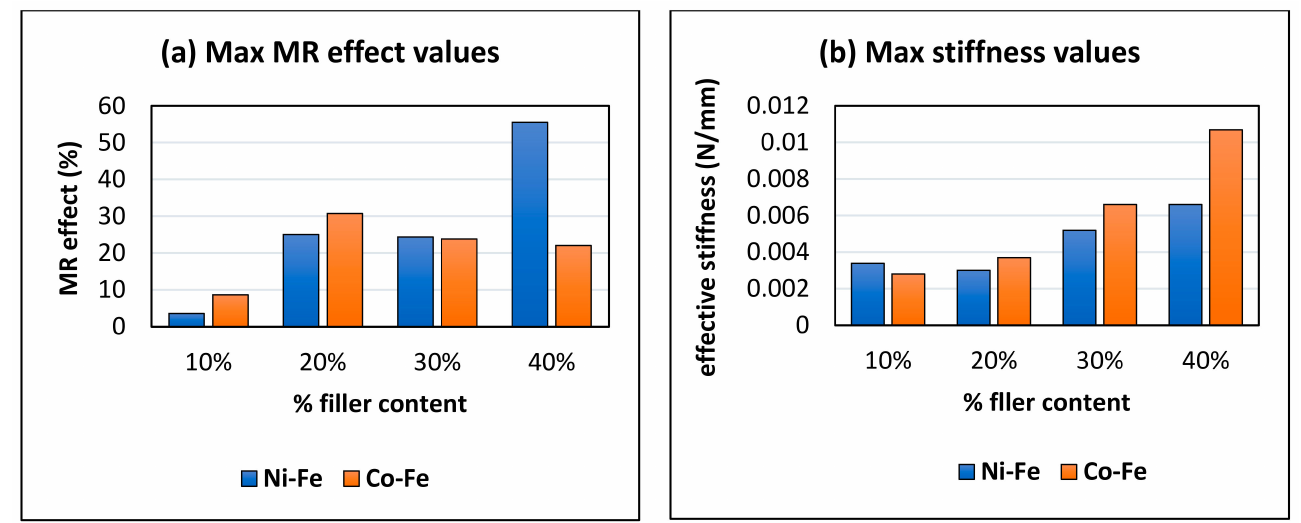
Figure 16. Comparison of ( a ) Maximum MR effect and ( b ) Maximum stiffness values for different %filler